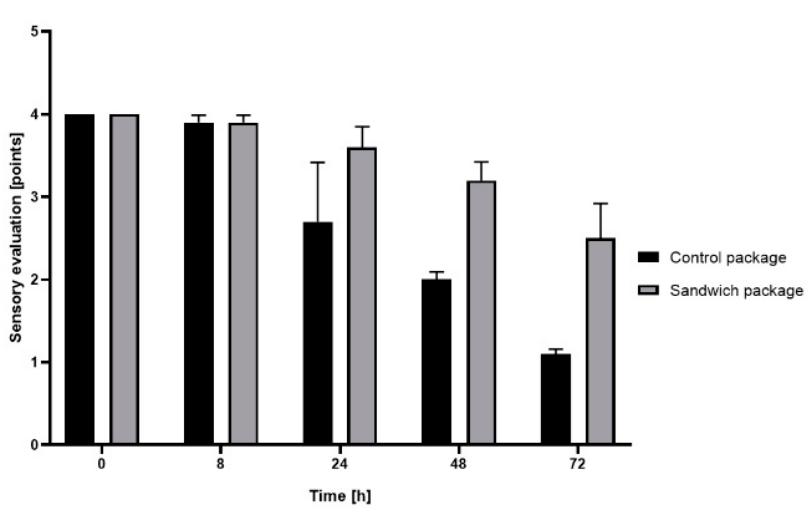
Figure 9. Sensory analysis of the bread after storage in the paper and the modified package.